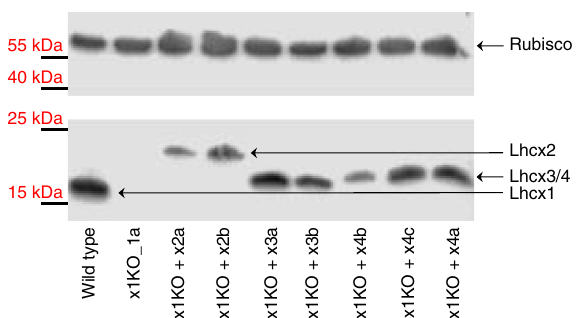
Fig. 2 Western blot of wild type, x1KO_1a and supplemented x1KO_1a strains. Cells were grown under low light. After blotting, the blot was cut and the upper part was incubated with a Rubisco antibody, whereas the lower part was incubated with the Lhcx antibody. Lhcx1 has the lowest molecular mass, Lhcx2 the highest, and Lhcx3 and Lhcx4 have a molecular mass in between. Protein mass marker bands are indicated on the left. Source data are provided as a Source Data fi